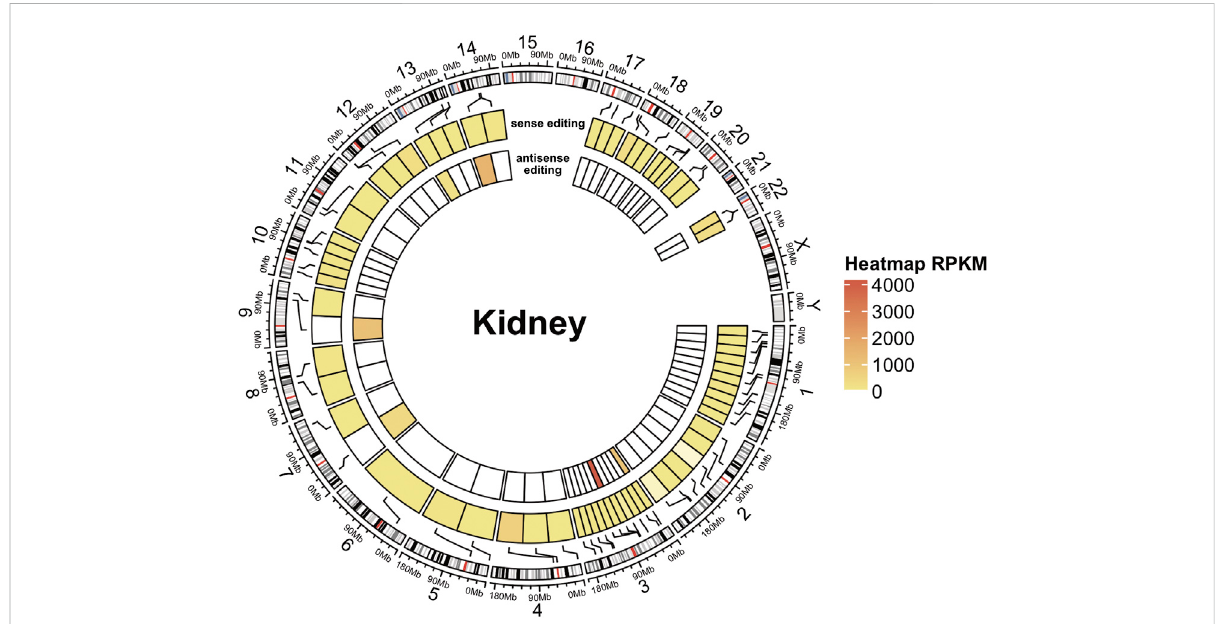
FIGURE 5 A-to-IantisenseRNAeditinginNGSdata.CircularheatmapforakidneyRNA-seqsample.Theexternalcirclerepresentsthechromosomes,and thetwoinnercirclesrepresentsense(intermediatecircle)andantisense(internalcircle)editing.A-to-IRNAeditinglocationsareindicatedwithblack lines connecting the heatmap to the cytoband context of the chromosomes (human genome assembly hg38). Editing levels are depicted in circular heatmaps using a color scale based on RPKM-like